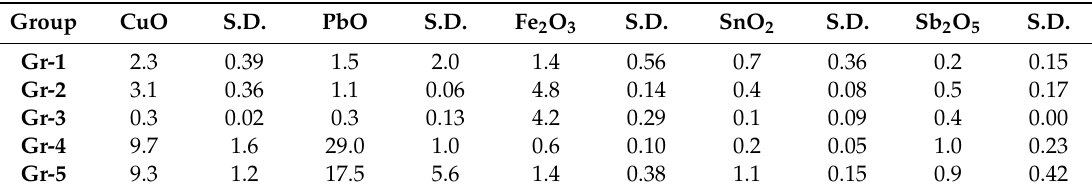
Table 4. Average chemical composition of copper (CuO), lead (PbO), iron (Fe 2 O 3 ), tin (SnO 2 ) and antimony (Sb 2 O 5 ) oxides for each hue group, with the respective standard deviation values. S.D.—standard